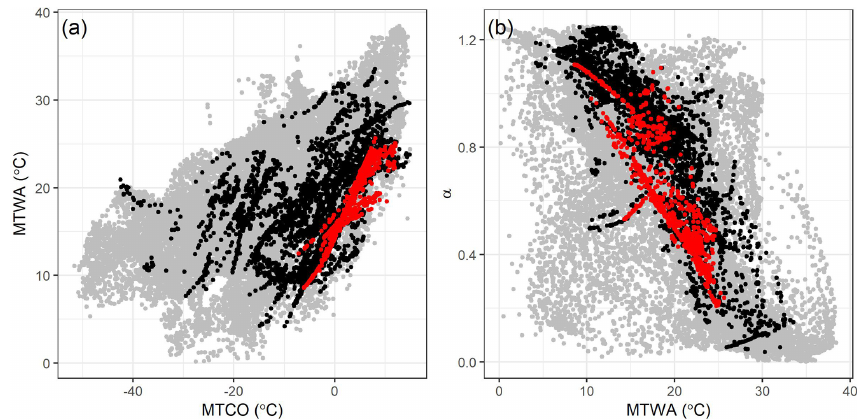
Figure 1. Climate space represented by mean temperature of the coldest month (MTCO), mean temperature of the warmest month (MTWA) and plant-available moisture as represented by α , an estimate of the ratio of actual evapotranspiration to equilibrium evapotranspiration. The grey points show climate values for a rectangular area (21 ◦ W–150 ◦ E, 29–82 ◦ N) enclosing the SMPDS, derived from the Climate Research Unit CRU CL 2.0 database (New et al., 2002). The black points show climate values of the SMPDS. The red points show climate values of the Iberian Peninsula region in the